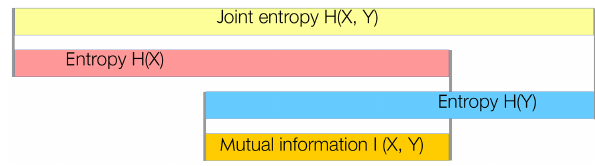
Figure 2. Sketch of the relation between information entropy, joint entropy and mutual information displayed as bar